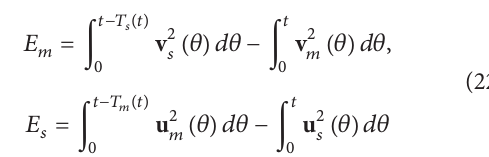
where 𝛽 𝑖 are positive constants for 𝑖 ∈ {𝑚, 𝑠}